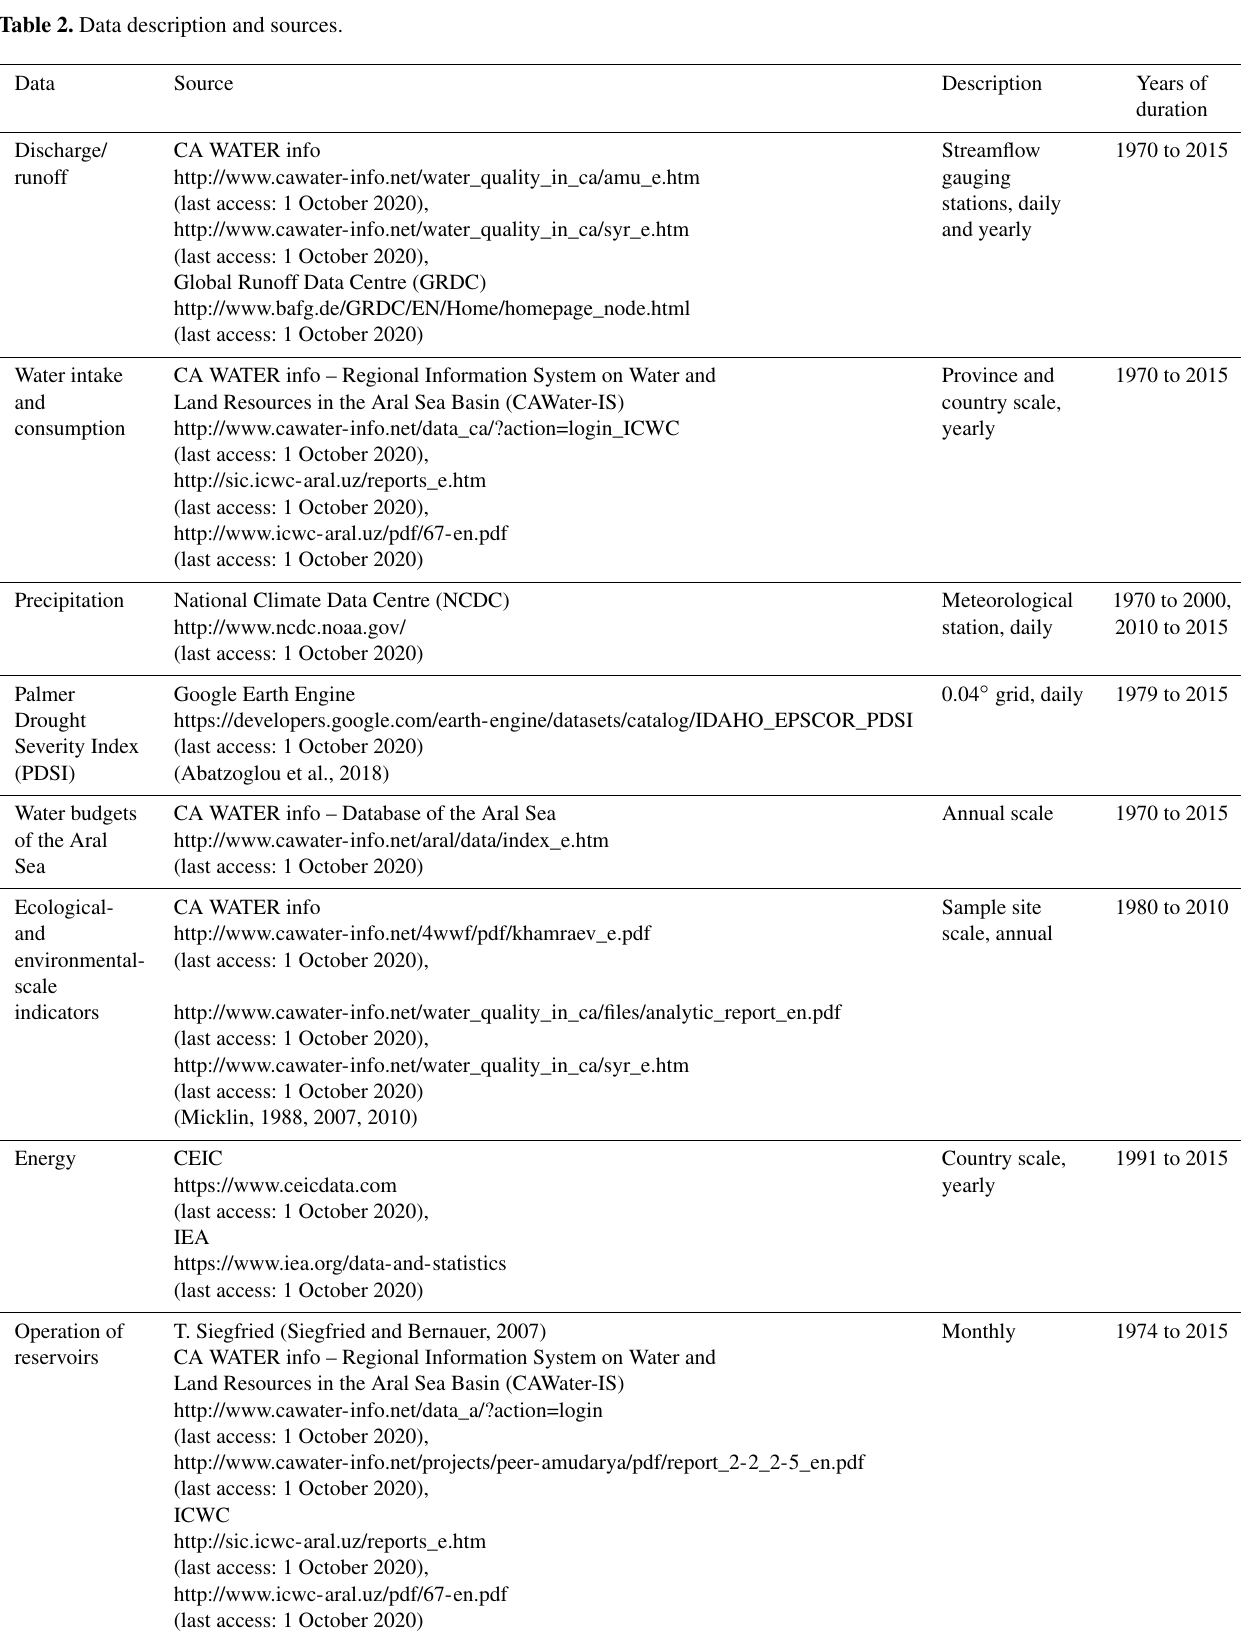
Table 2. Data description and